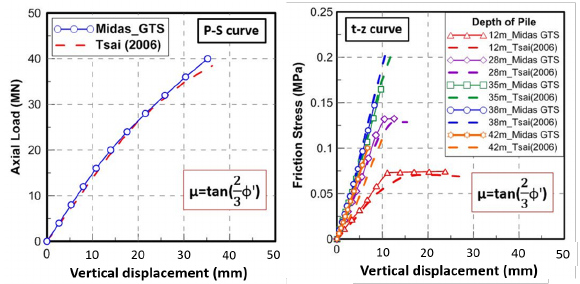
Fig. 4. Comparison of solutions from Midas analysis